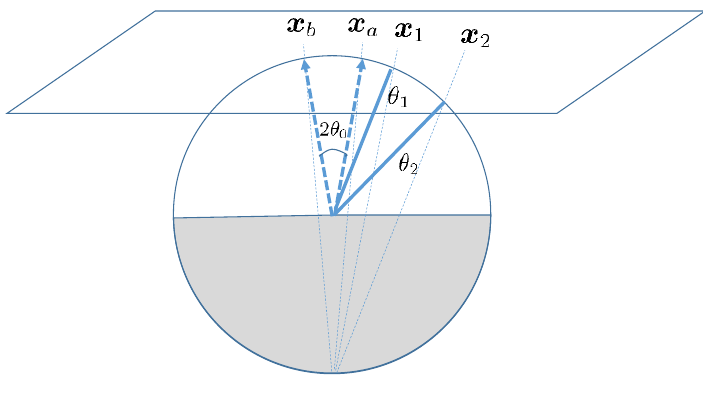
Figure 6 . The stereographic projection for the case where the di-jets are boosted along the positive z axis. The original quark and antiquark, as represented by dashed lines, make a small angle 2 (cid:18) 0 and are projected onto the points with coordinates x a and x b in the transverse plane. Two successive soft gluon emissions, with increasing angles (cid:18) 0 (cid:28) (cid:18) 1 (cid:28) (cid:18) 2 , are projected onto points with increasing transverse coordinates, j x a (cid:0) x b j (cid:28) j x 1 j (cid:28) j x 2 j . The projection relates the anti-collinear time-like evolution to the anti-collinear space-like